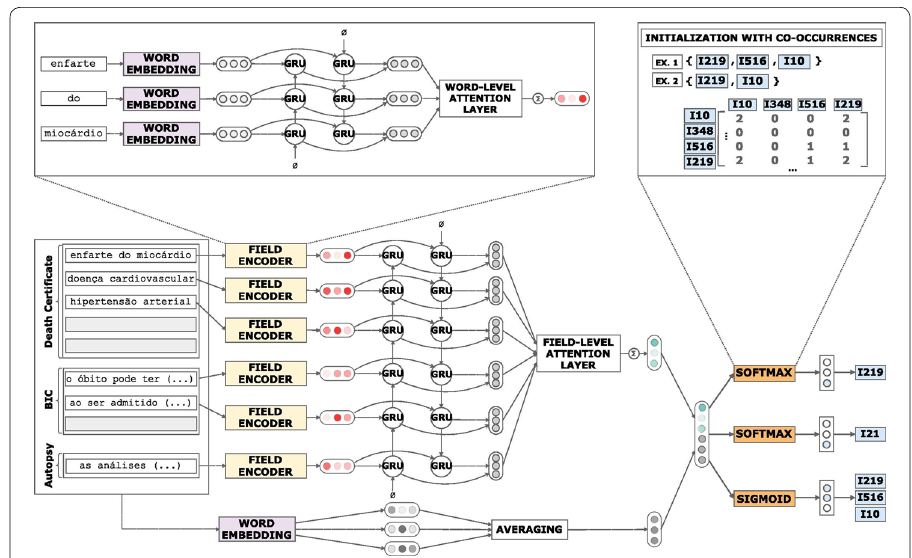
Fig. 3 Architecture diagram copied from Duarte et al.